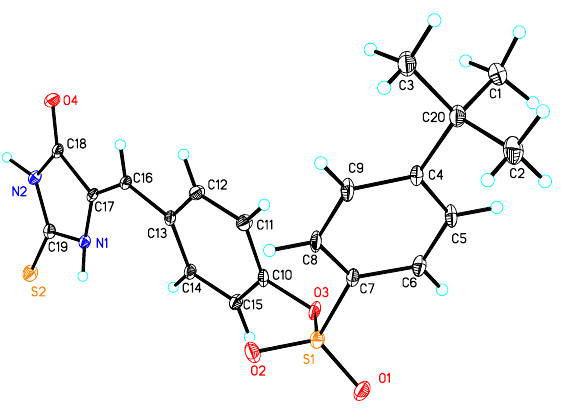
Figure 1. X-ray structure of compound 2k .